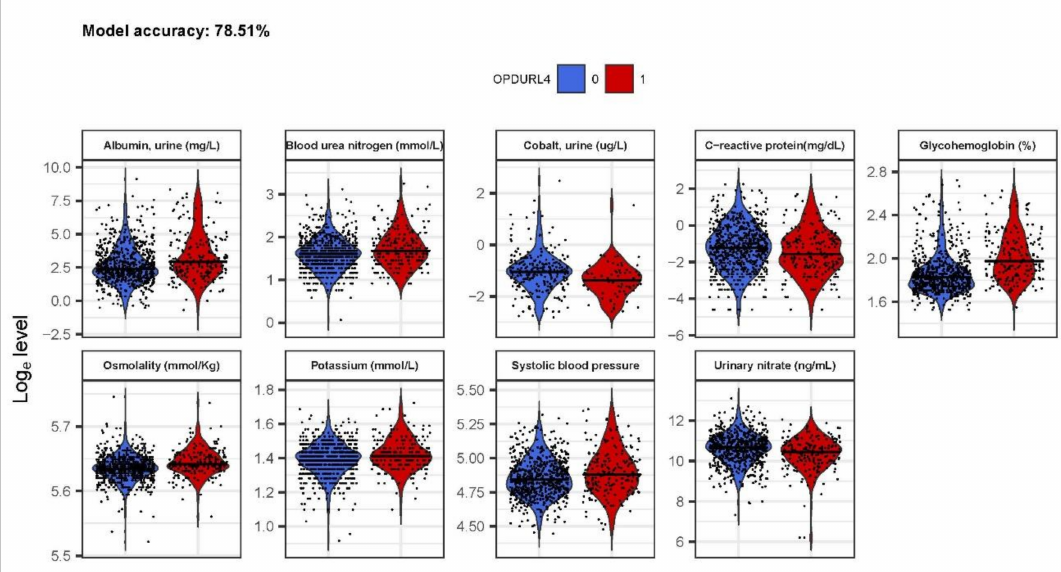
Figure 2. Penalised regression-selected variables. Variables were selected from a 100 × cross-validated model with α = 0.5. Final variable selection was based on coe ffi cients not shrunk to 0. Model accuracy was determined to be 78.4% accuracy and AUC 0.71 (95% CI: